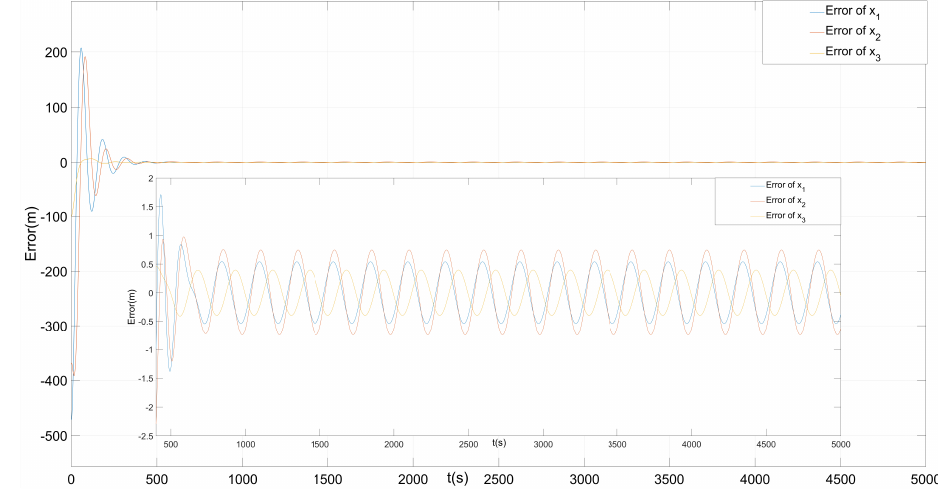
Figure 4. Error between the system and model.